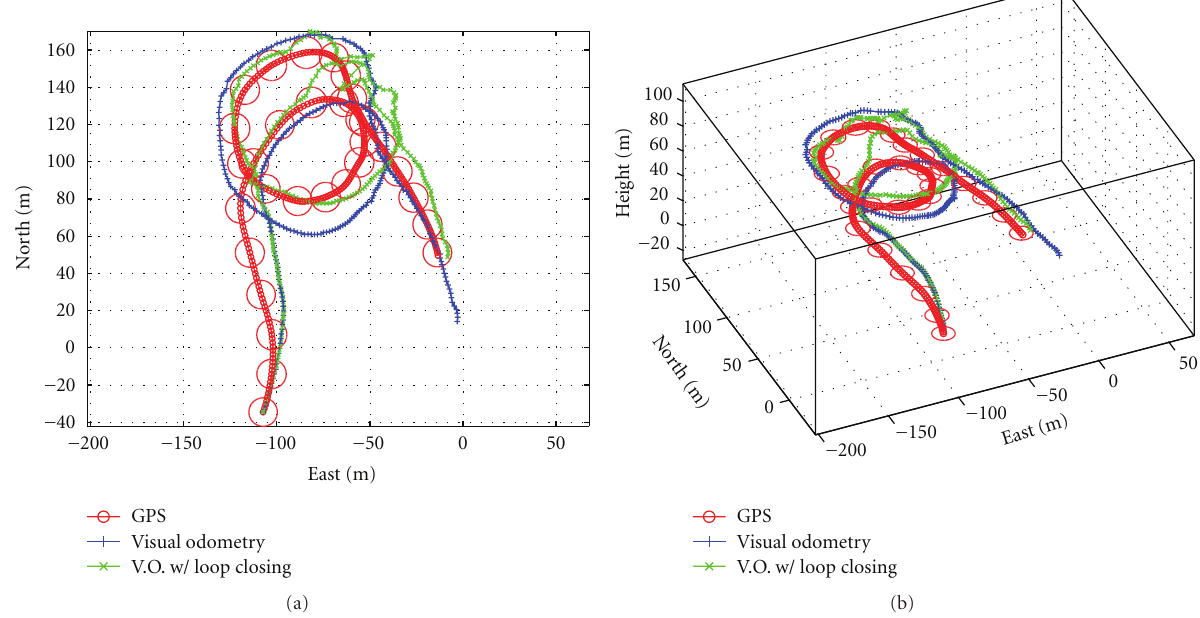
Figure 15: The airship trajectory recovered by visual odometry before and after applying the graph optimization package. Table 4: Comparison of visual odometry before and after loop-closing, with the GPS as reference. All values are given in meters. Unit: